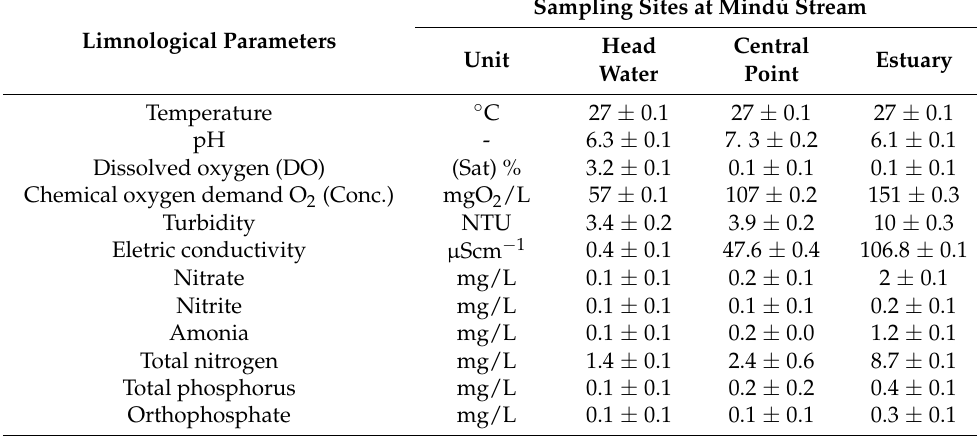
Table 1. Mean values and standard deviation of the limnological parameters measured at the various sampling